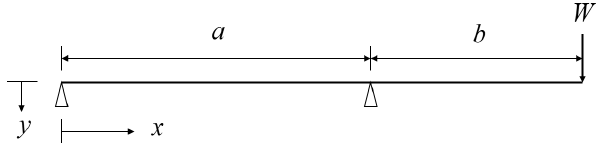
Figure 5. Shaft bending deflection in one-end weight.